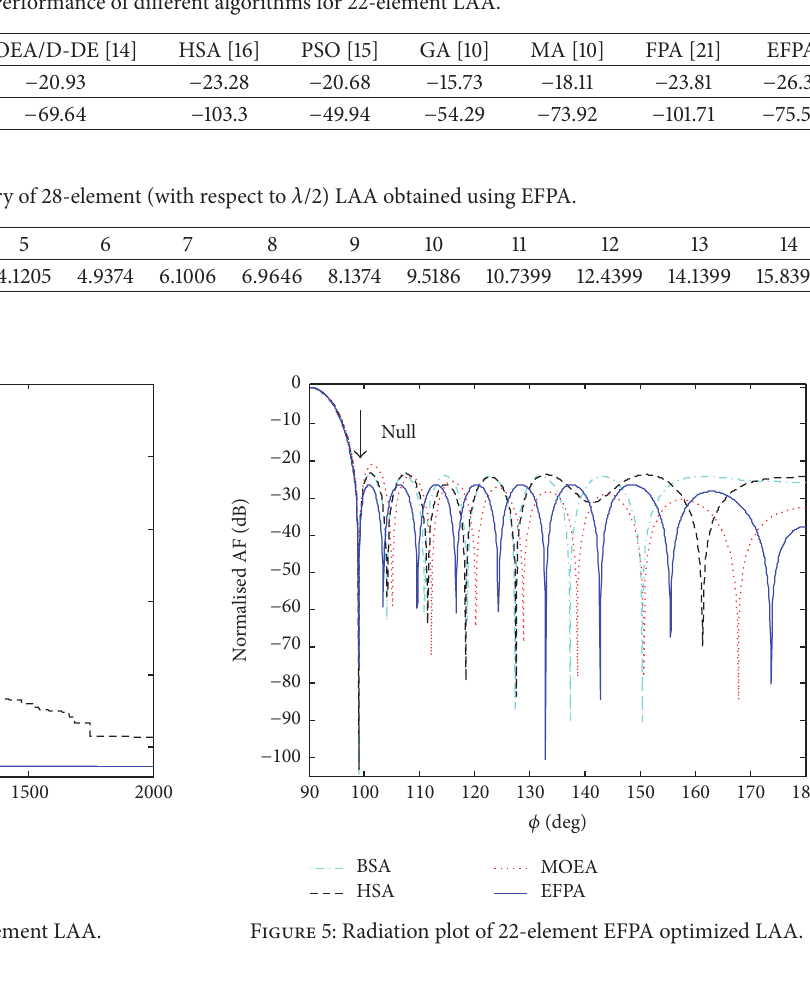
Table 9: Performance of different algorithms for 22-element LAA.